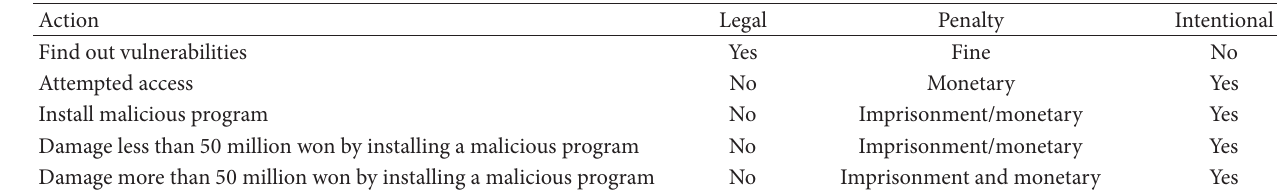
Figure 2: Legal comparison between port scan and snoop. Table 3: The improved punishment criteria for